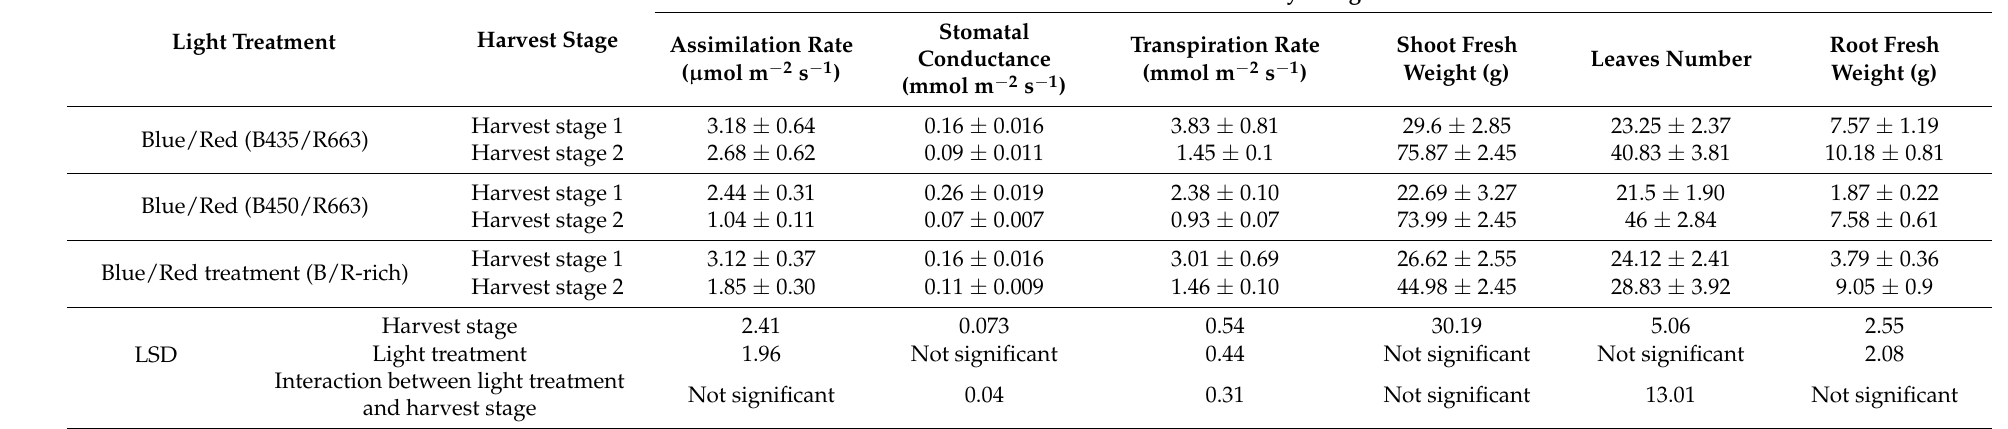
Table 2. The effects of low light intensity of different LEDs treatments on A: Assimilation rate (for harvest stage ( p ≤ 0.001), for light treatments ( p = 0.003), and for interaction between harvest stage and light treatments ( p = 0.605)). B: Stomatal conductance (for harvest stage ( p ≤ 0.001), for treatment ( p = 0.072), and for interaction between harvest stage and light treatments ( p ≤ 0.001)). C: transpiration rate (for harvest ( p = 0.002) for light treatments ( p = 0.003) and for interaction between harvest stage and light treatments ( p = 0.31)). D: Shoot fresh weight (g) (for harvest stages ( p = 0.001), for light treatments ( p = 0.078), and interaction between harvest stage and light treatments ( p = 0.069)). E: Root fresh weight (g) (for harvest ( p ≤ 0.001) for light treatments ( p = 0.013), and for interaction between harvest stage and light treatments ( p = 0.210)), F: leaves number (for harvest stage ( p ≤ 0.001), for light treatments ( p = 0.07) for interaction between harvest stage and light treatments ( p =